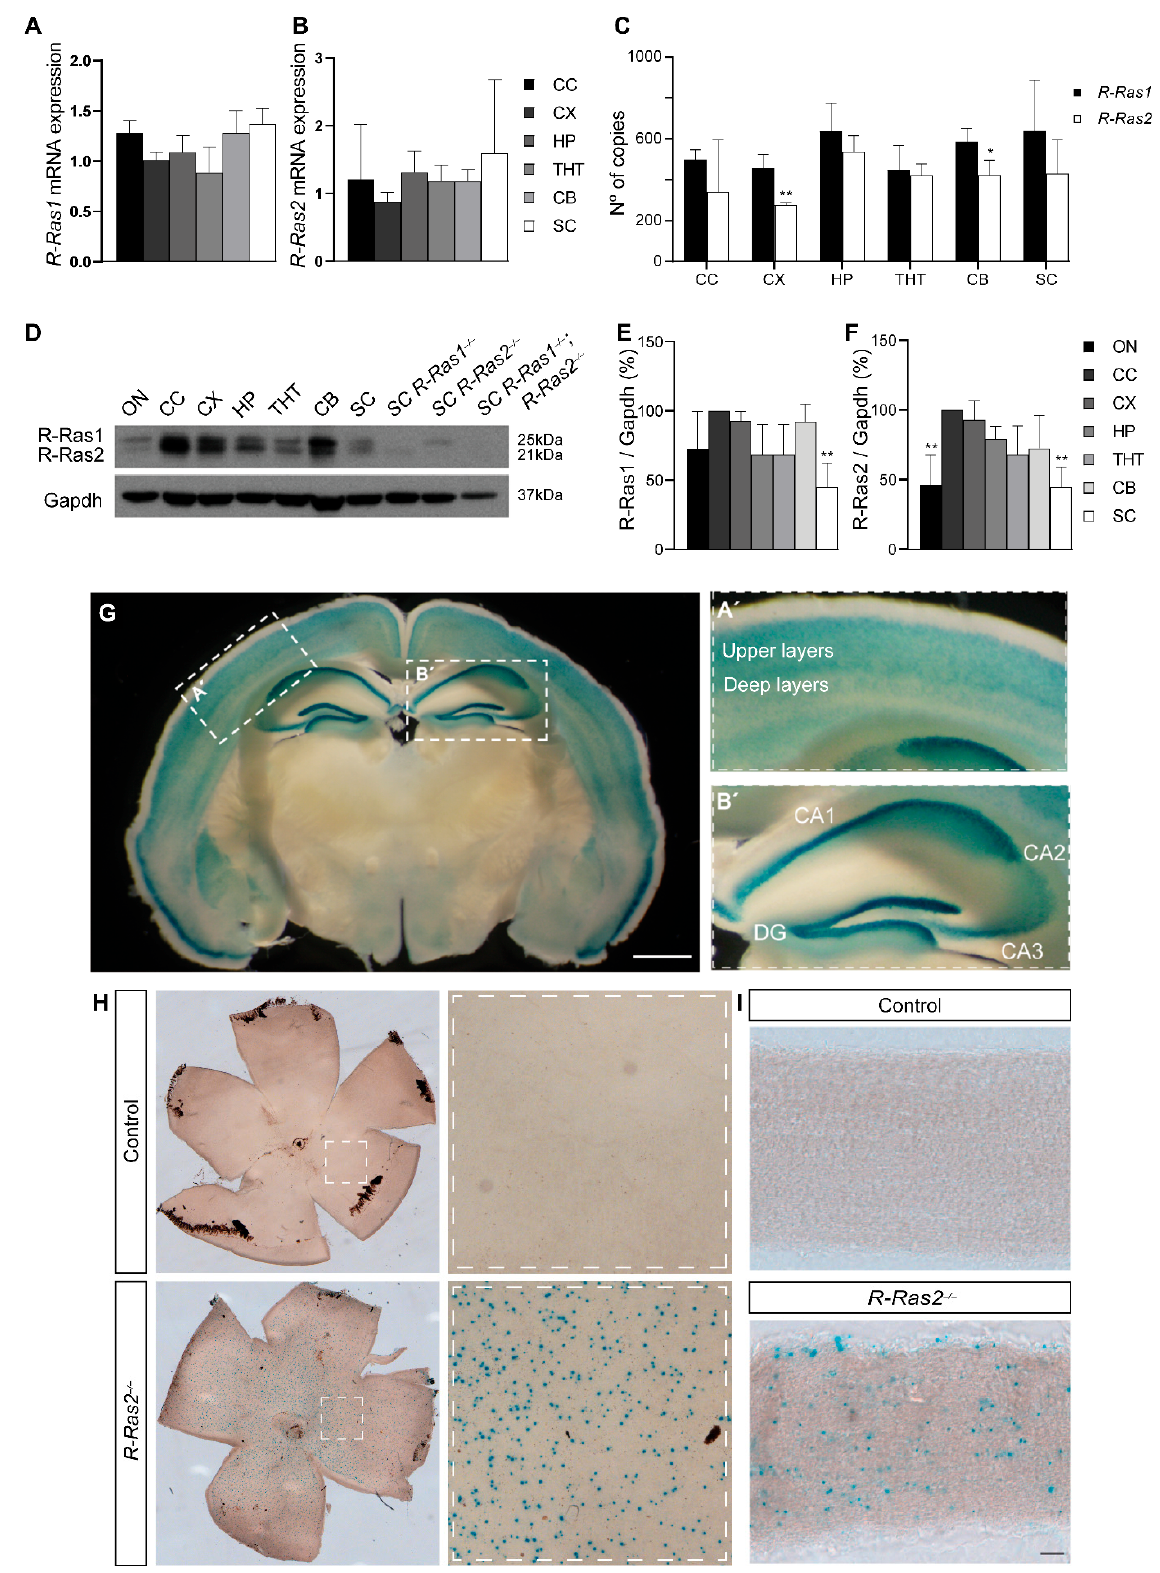
Figure 2. R-Ras1 and R-Ras2 expression in different CNS regions. ( A ) Relative RT-qPCR experiments show relative expression of R-Ras1 in the CC, CX, HP, THT, CB, and SC of control adult mice (P90); there were no differences in R-Ras1 mRNA expression across tissues. ( B ) RT-qPCR experiments display relative expression of R-Ras2 in the CC, CX, HP, THT, CB, and SC of control adult mice (P90); there were no differences in R-Ras2 mRNA expression across tissues. ( C ) Absolute RT-qPCR experiments show number of mRNA copies of R-Ras1 and R-Ras2 in the CC, CX, HP, THT, CB, and SC of control